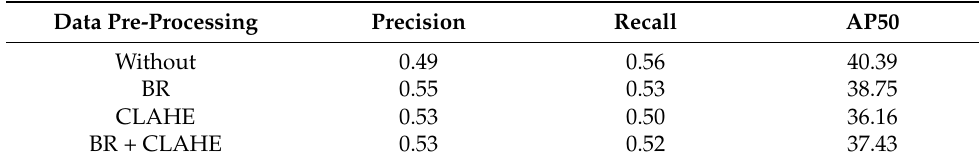
Table 5. Experimental results at the bounding box level.